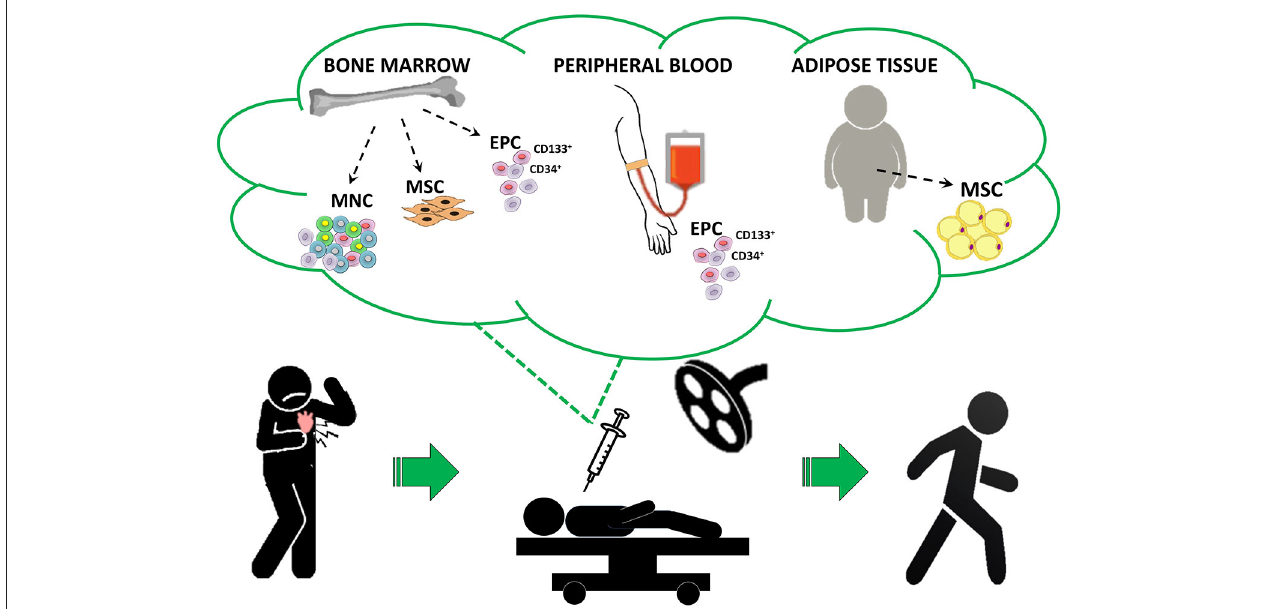
FIGURE 1 | Proposed cell therapy approach for refractory angina patients. The figure represents the ideal in-hospital protocol of different cell-based therapies for RA following a gold standard approach. EPC, endothelial progenitor cells; MNC, mononuclear cells; MSC, mesenchymal stem cells.